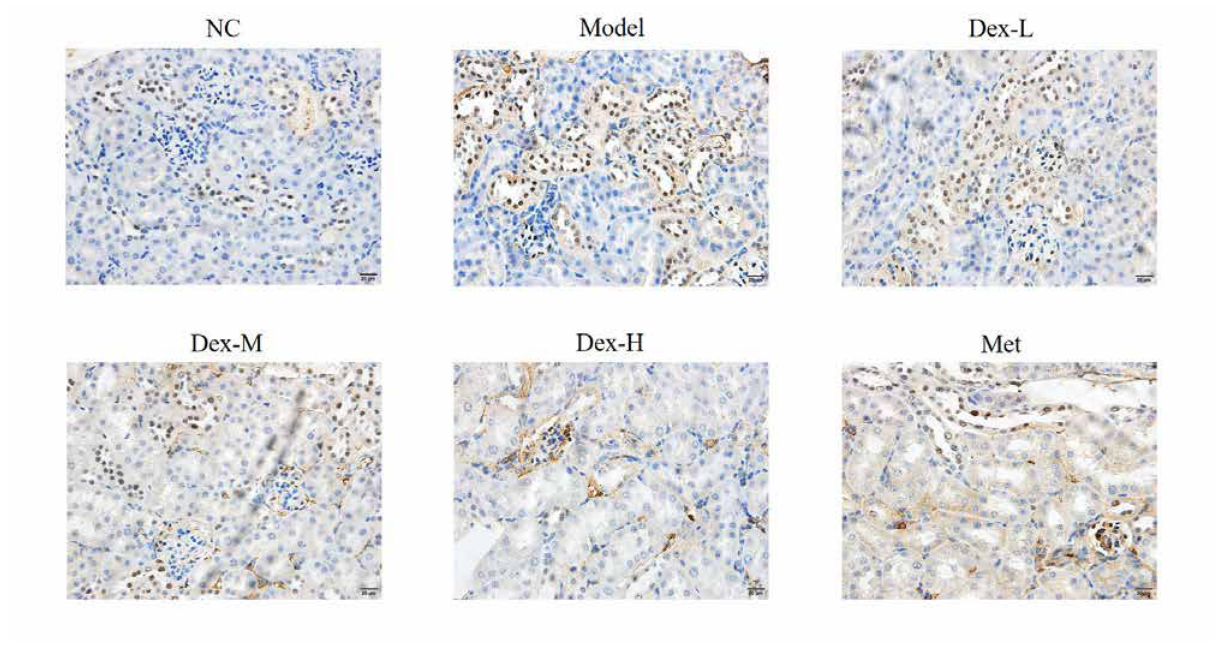
Figure 8: The Nox4 protein expression of different groups by IHC assay (400×) NC: normal control group; Model: DN model group; Dex-L: Dex low-dose treated group; Dex-M: Dex medium-dose treated group; Dex-H: Dex high-dose treated group; Met: Metformin treated